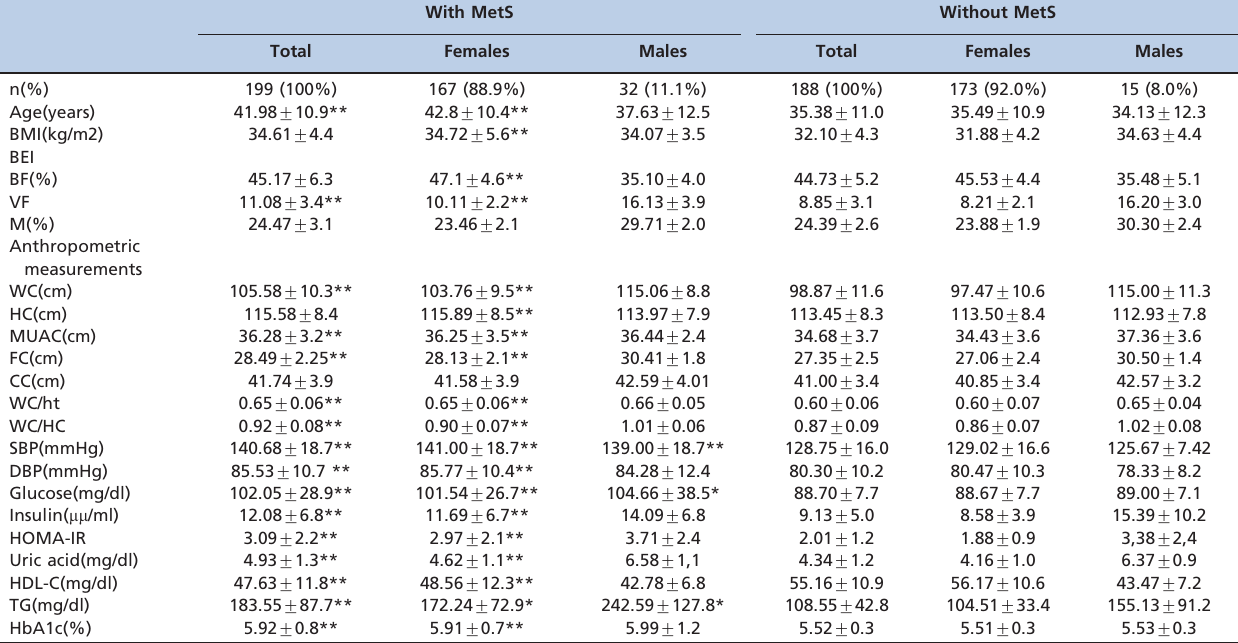
Table 1 - Descriptive characteristics, anthropometric indices, body composition, and metabolic risk parameters of the study population with and without MetS. n, (%), mean ¡